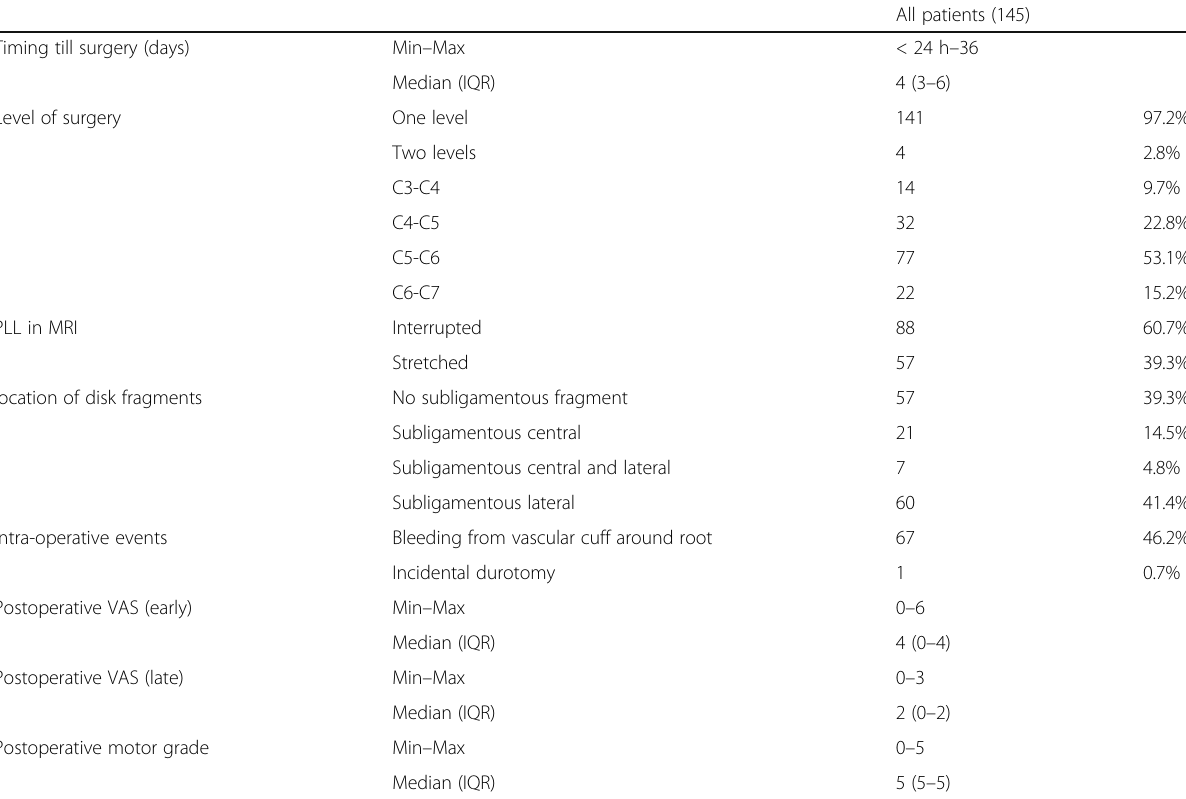
Table 2 Operative details, complications, and degree of pain and motor grade ( n =